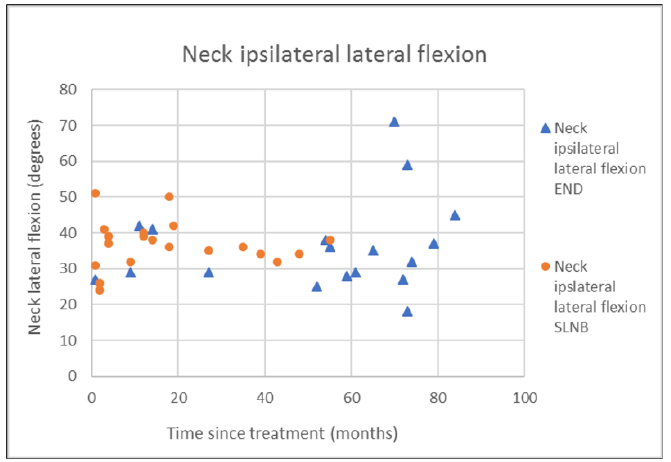
Figure 9. Neck ipsilateral lateral flexion in relation to time since treatment.